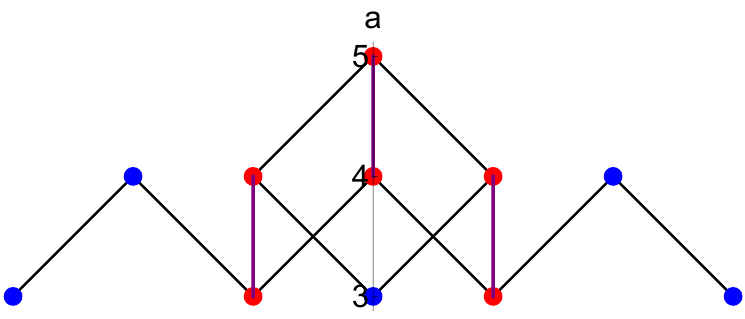
Figure 9 . Homological diagram for 8 19 knot. The pairs of generators shown in red, connected by vertical purple segments, correspond to monomials in the superpolynomial that are cancelled upon setting a = 1 and t = − 1